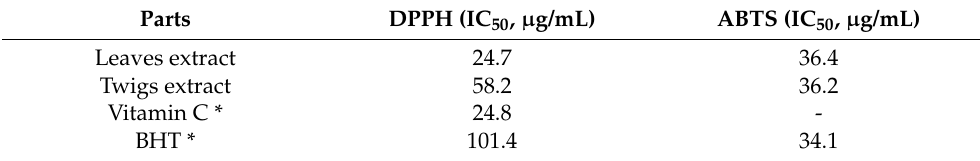
Table 1. DPPH and ABTS radical-scavenging activities of leaf and twig extracts from P. macrophyllus